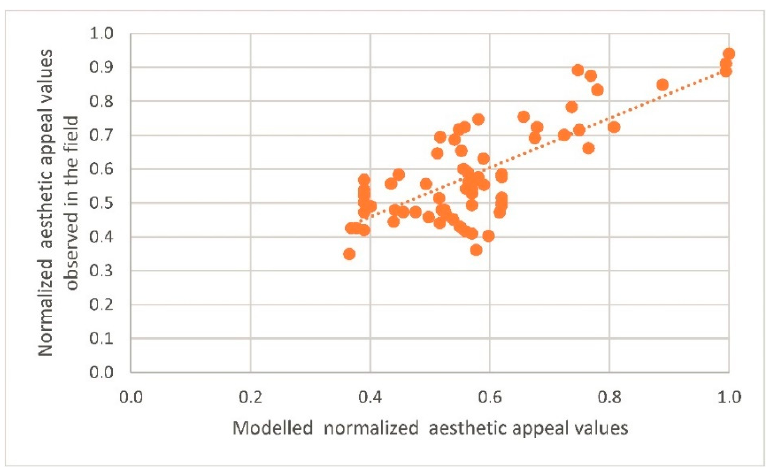
Figure 12. Pearson’s correlation between the modelled and observed short-range aesthetic appeal values at 100 viewpoints ( r = 0.77, p < 0.0005). (Computed and drawn by Arvydas Urbis).